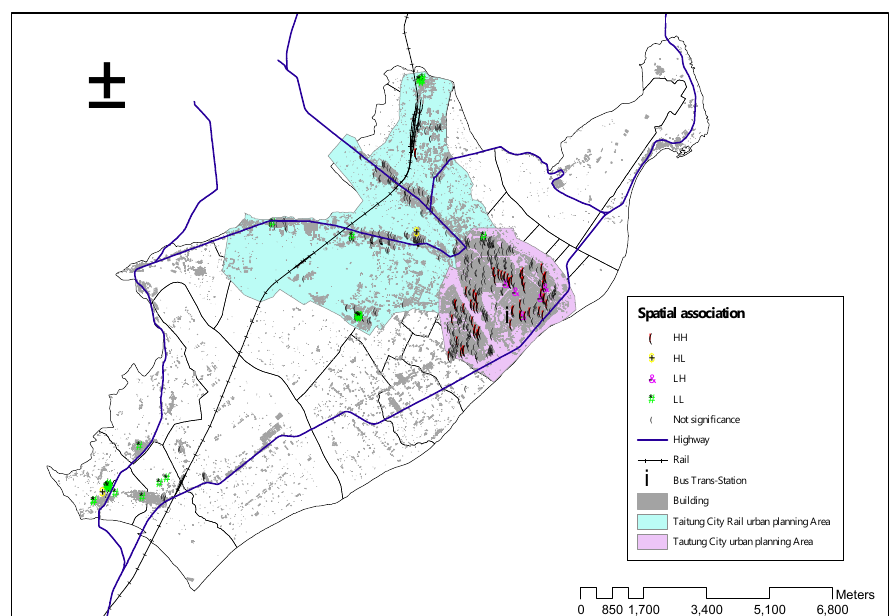
Figure 5. Spatial correlation map of real estate unit price in 2015.